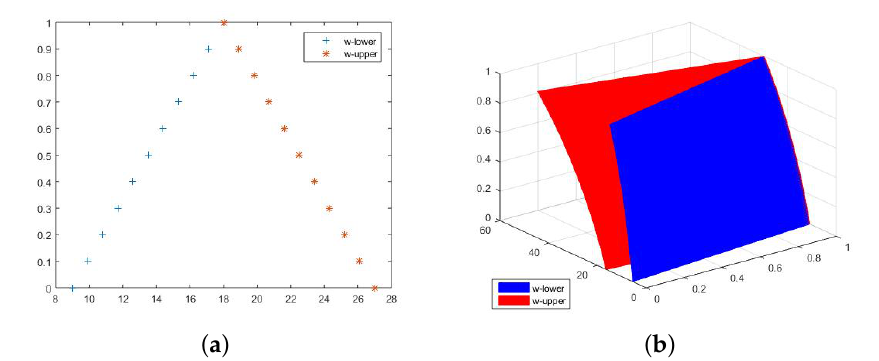
Figure 4. The exact lower and upper solutions of Equation (144) at Λ = 0.5, t = 2, (cid:61) = 1, ı = 1. ( a ) 2 D figure for exact solutions of one-dimensional fuzzy fractional diffusion equation of w in Example 8. ( b ) 3 D figure for the exact solutions of w in Example